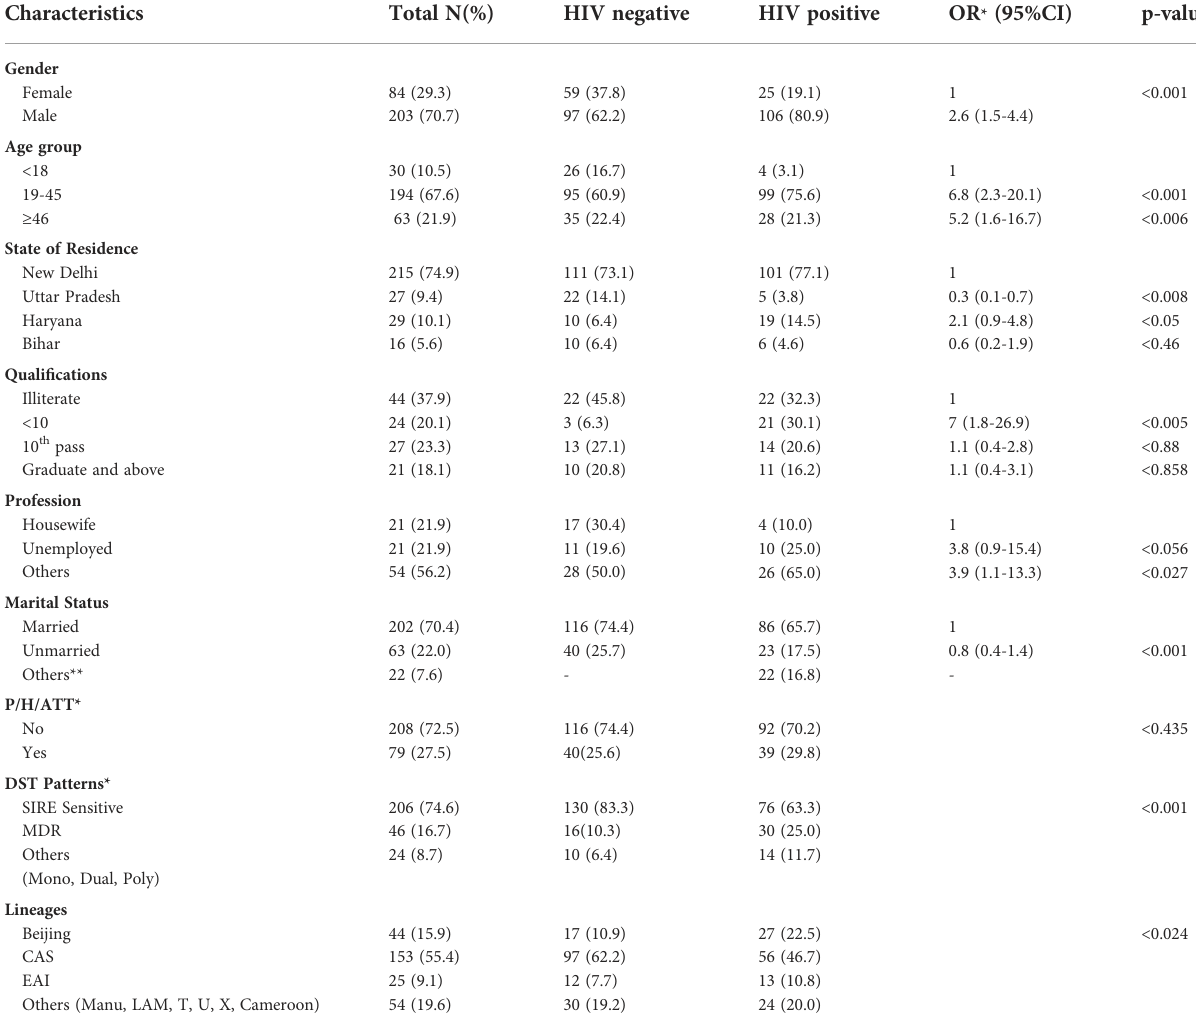
TABLE 1 Demographic details of the patients, drug resistance patterns, and phylogenetic lineages of the MTB isolates.